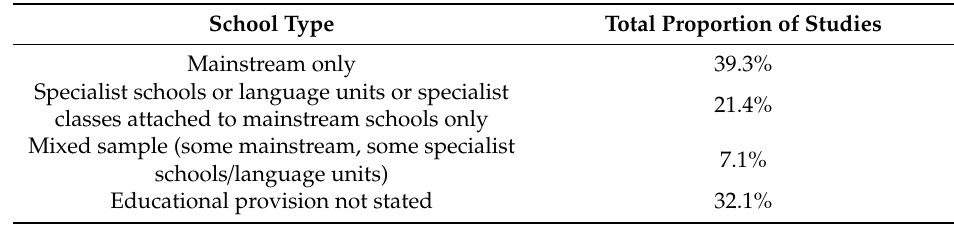
Table 3. Table showing proportion of studies containing samples enrolled in di ff erent types of